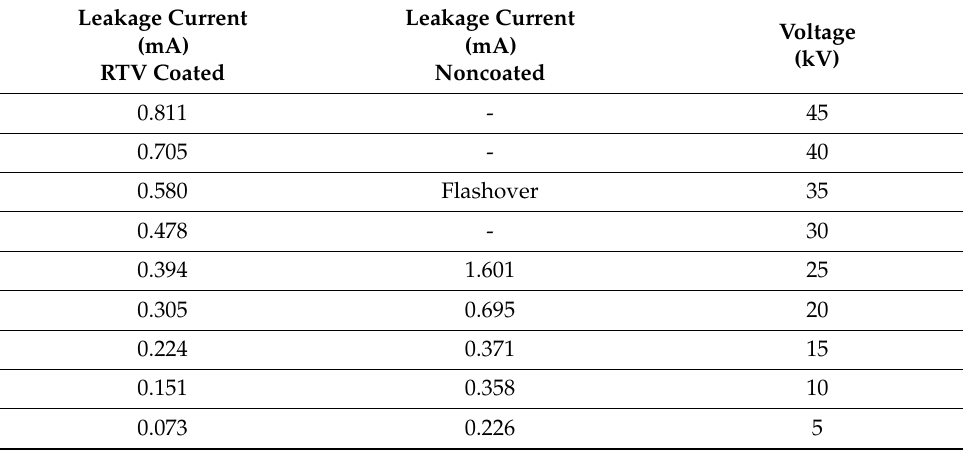
Table 3. The magnitude of insulator leakage current.